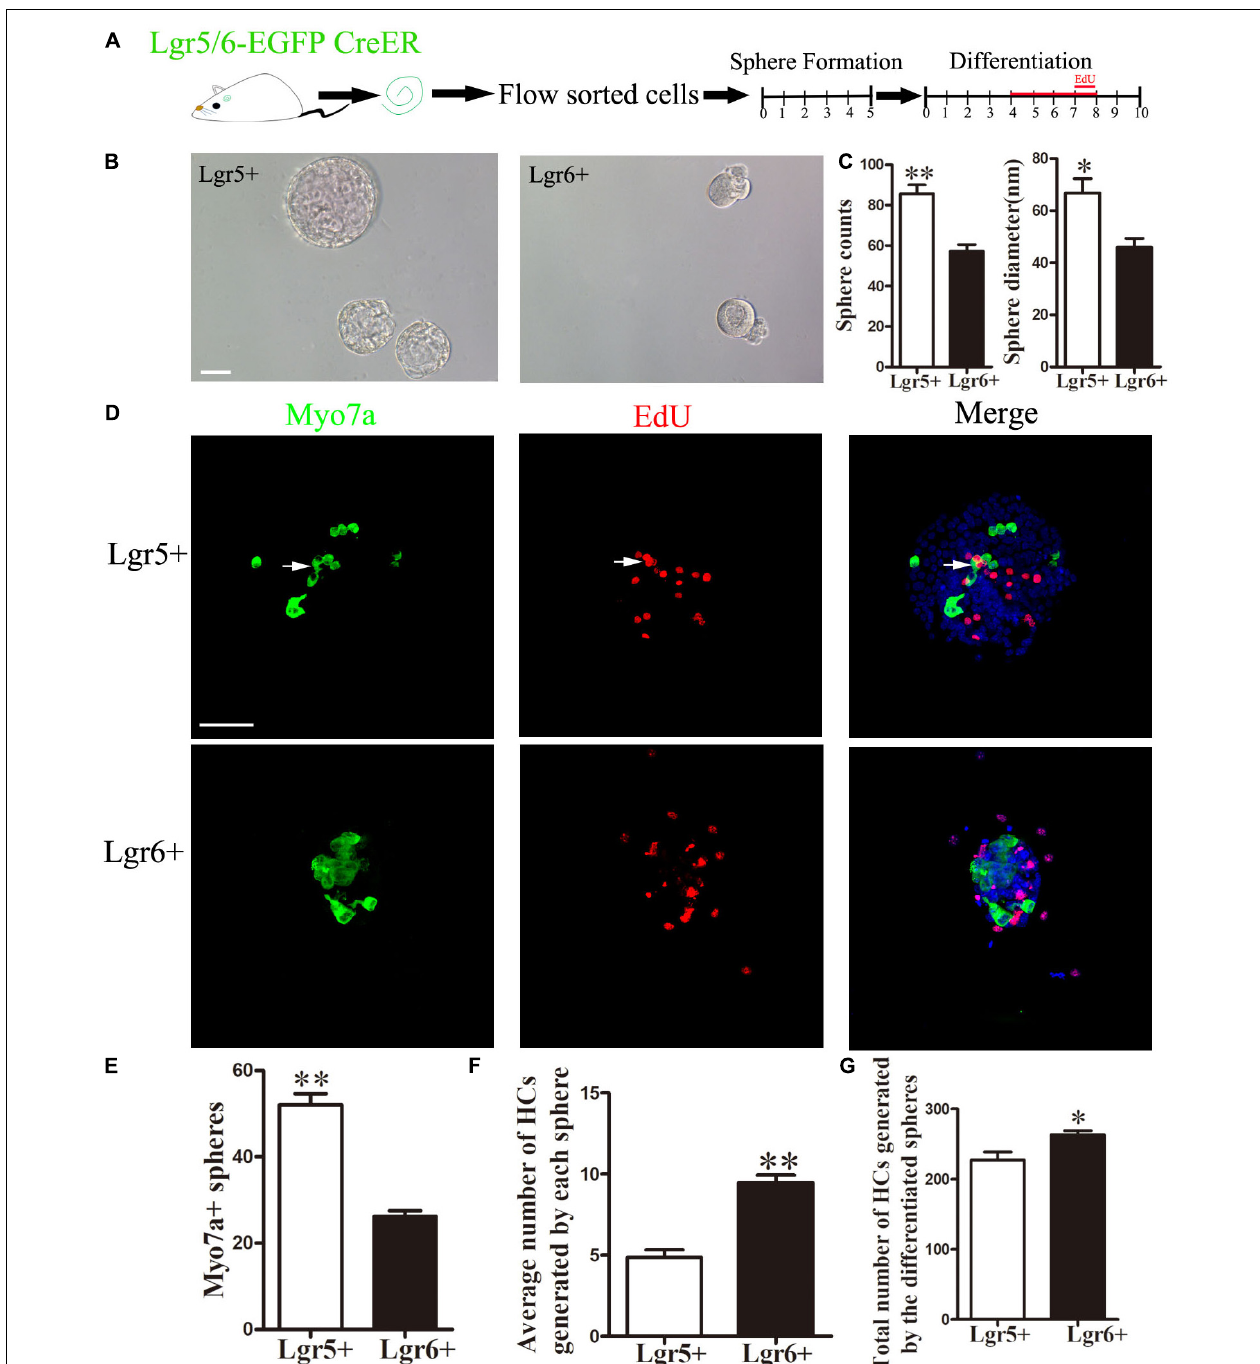
FIGURE 3 | Lgr5 + progenitors have greater sphere-forming ability than Lgr6 + progenitors, and Lgr6 + progenitors have greater differentiation ability than Lgr5 + progenitors (A) Schematic depicting the experimental procedure. Cochleae were dissected, and flow-sorted Lgr5 + and Lgr6 + progenitors were cultured for 5 days in ultra low-attachment dishes, after which the spheres were transferred to laminin/polylysine (1:1)-coated 4-well dishes and cultured for another 10 days with EdU added to the medium from day 4 to day 8. (B) Both Lgr5 + and Lgr6 + progenitors could generate spheres. (C) Lgr5 + progenitors generated significantly more spheres than Lgr6 + progenitors, and spheres from Lgr5 + progenitors had a significantly larger diameter than those from the Lgr6 + progenitors. (D) Differentiated spheres from Lgr5 + progenitors generated Myo7a + HCs and Myo7a + /EdU + double-positive cells (arrows). Differentiated spheres from Lgr6 + progenitors also generated Myo7a + HCs. (E) Lgr5 + progenitors generated significantly more Myo7a + spheres than those from Lgr6 + progenitors. (F) Each differentiated sphere from Lgr6 + progenitors generated significantly more Myo7a + HCs than those from Lgr5 + progenitors. (G) The 2,000 differentiated spheres from Lgr6 + progenitors generated significantly more Myo7a + HCs than those from Lgr5 + progenitors. ∗ p < 0.05; ∗∗ p < 0.01, n = 4. Scale bars are 50 µ m.